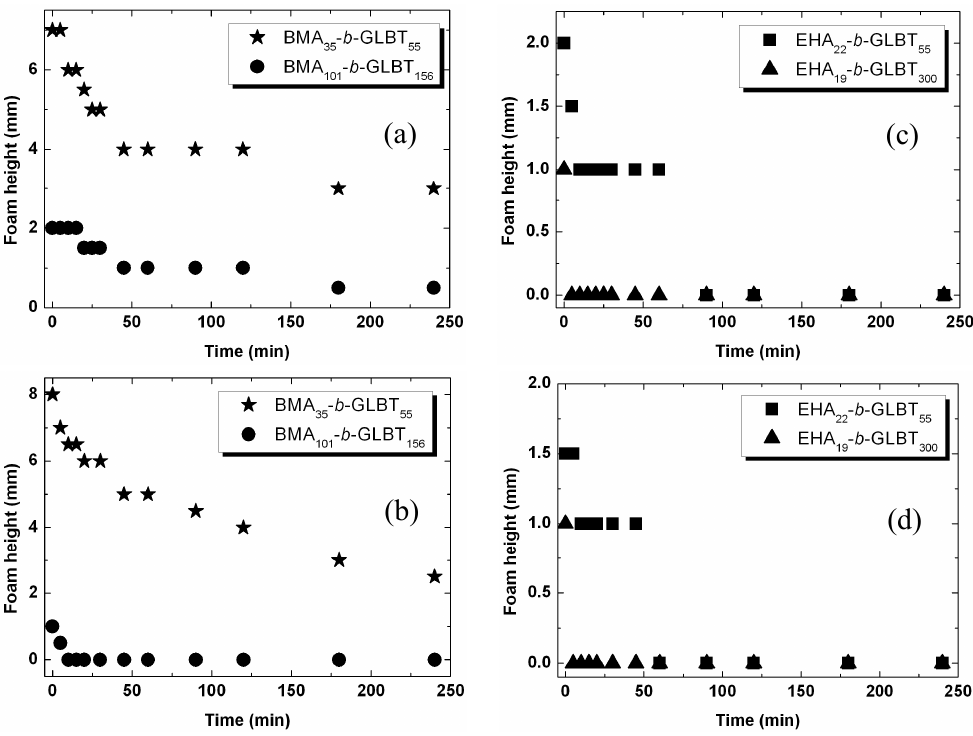
Figure 5. Time-dependent foam height of different ZABC solutions with P( n -BMA) and PEHA (concentration = 1 mg/mL): ( a , c ) in water; and ( b , d ) in 1 M NaCl.